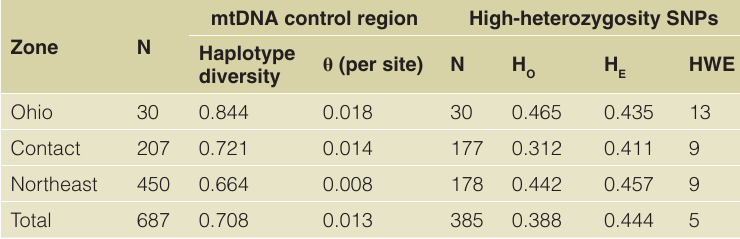
Table 2. Genetic diversity of eastern coyotes ( Canis latrans ) measured with mtDNA sequences and 16 nuclear SNP genotypes. Most individuals genotyped at 16 nuclear SNPs represent a subset of those individuals sequenced.